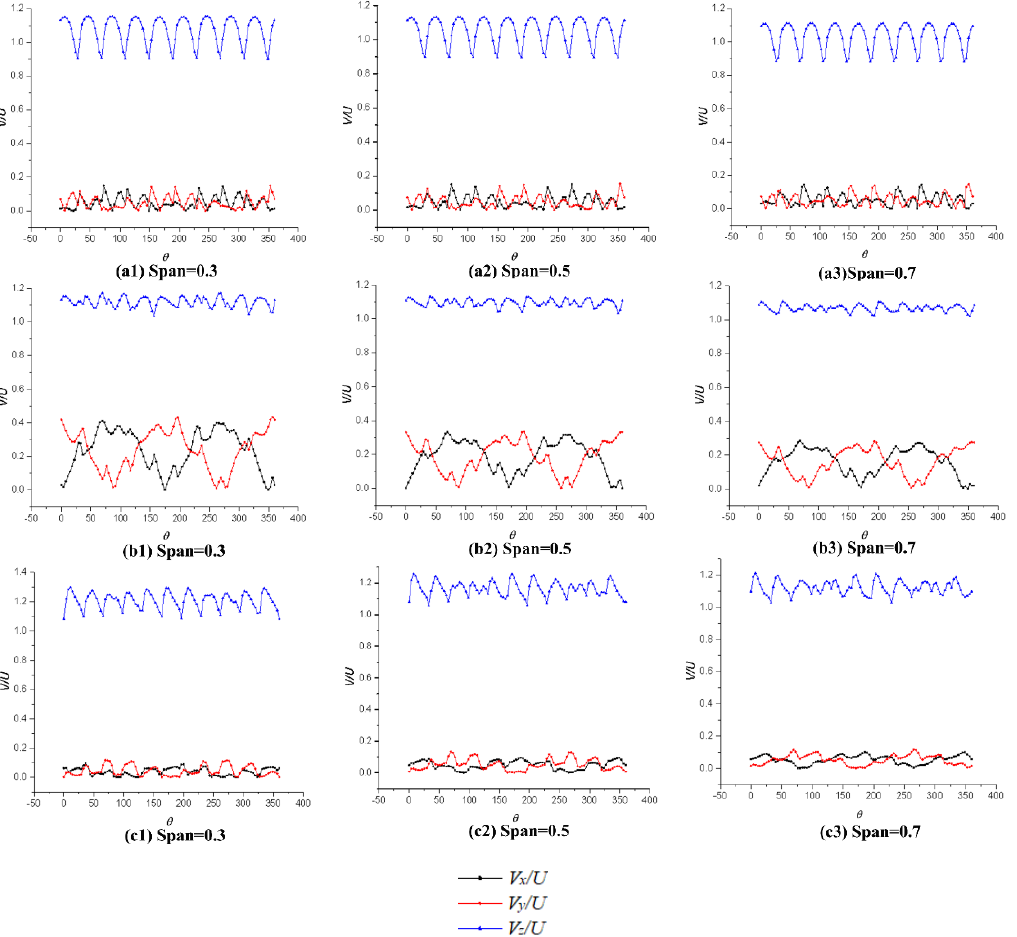
Figure 34. Velocity distribution of pump-jet designed by inverse design method (a1, a2, a3 are rotor inlet, b1, b2, b3 are between rotor and stator, c1, c2, c3 are stator outlet).